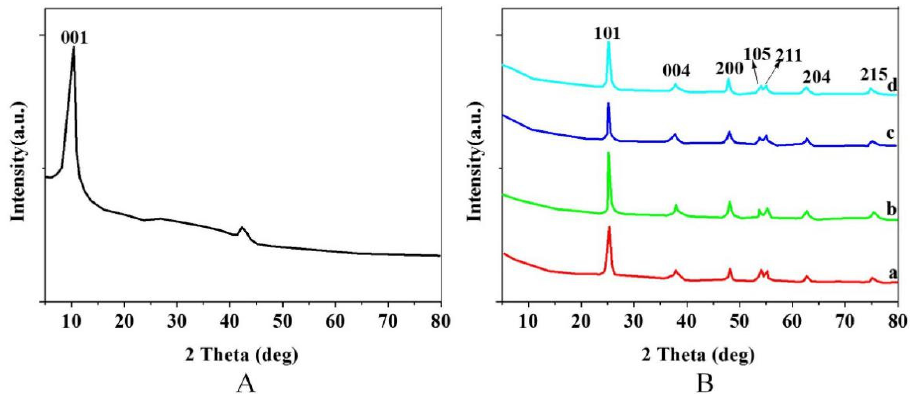
Figure 3. XRD spectrograms of the different samples (( A ) GO; ( B ): a. TiO 2 ; b. GO; c. N-TiO 2 ; d. TiO 2 /GO; e. N-TiO 2 /GO)).